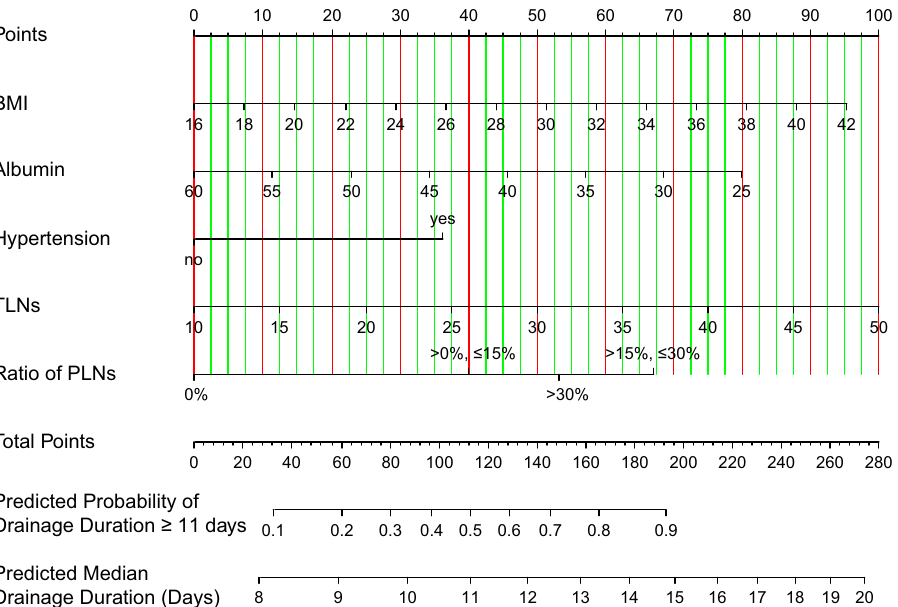
Figure 1. Nomogram to predict the median drainage duration of axillary suction drain and the probability of retaining the suction drain during drainage. BMI, body mass index; PLNs, positive axillary lymph nodes; TLNs, number of total dissected axillary lymph nodes.